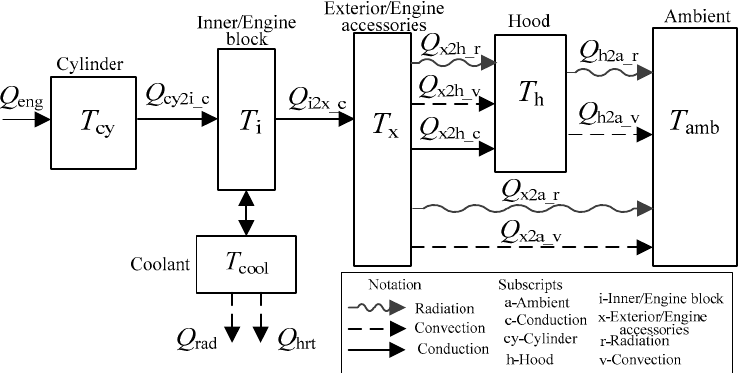
Figure 2. Schematic illustration of the engine thermal model.